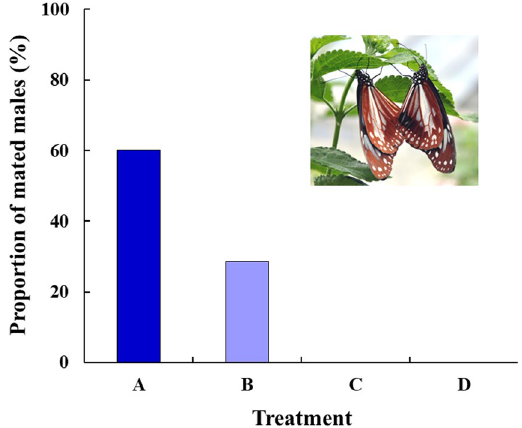
Figure 2. Mating success of Parantica sita males fed with different PA substances. The substances and their total quantities per male fed to the four cohorts were as follows: A, I/L (1.5 mg); B, I/L (0.5 mg); C, heliotrine (1.5 mg); and D, the hydrolysate mixture of I/L (1.5 mg). The numbers of males per cohort and females potentially engaged in the mating behaviour at any time point during the experiment, were 5 and 16, respectively. The proportion of mated males in A differed significantly from that in C and D ( p < 0.05). The photograph shows a pair in copula (left, female; right, male).